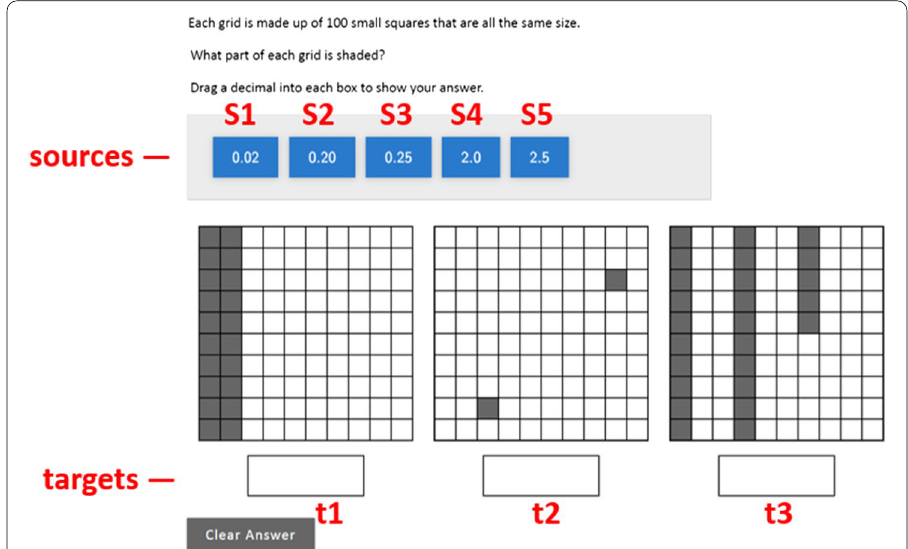
Fig. 2 Screenshot of a released drag‑and‑drop item administered to fourth‑grade students (G4 item) in the 2017 NAEP mathematics assessment. The sources and targets are denoted in